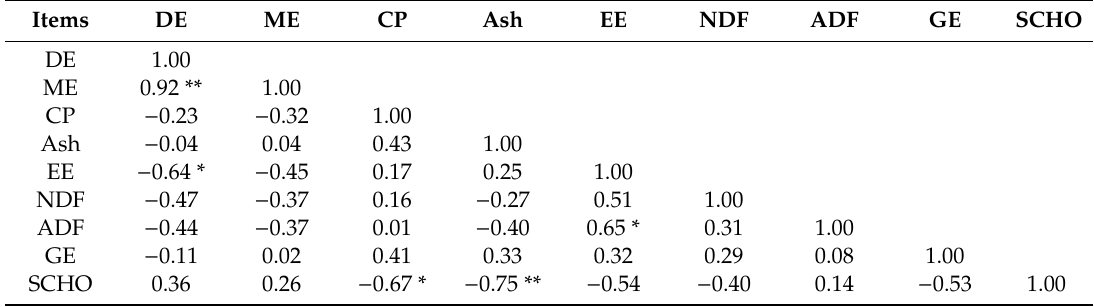
Table 7. Correlation coe ffi cients among chemical compositions and energy in the corn 1 .